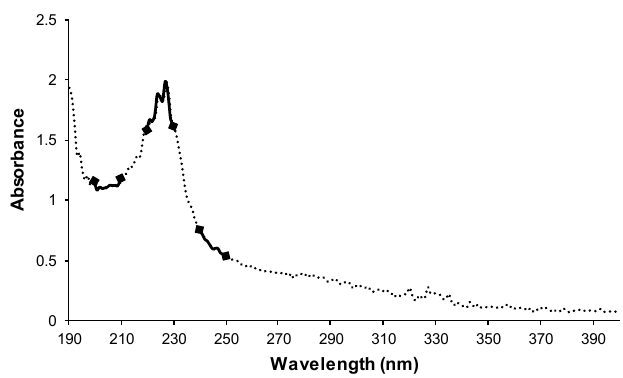
Figure 1. Typical UV-VIS spectrum (1/25 dilution).